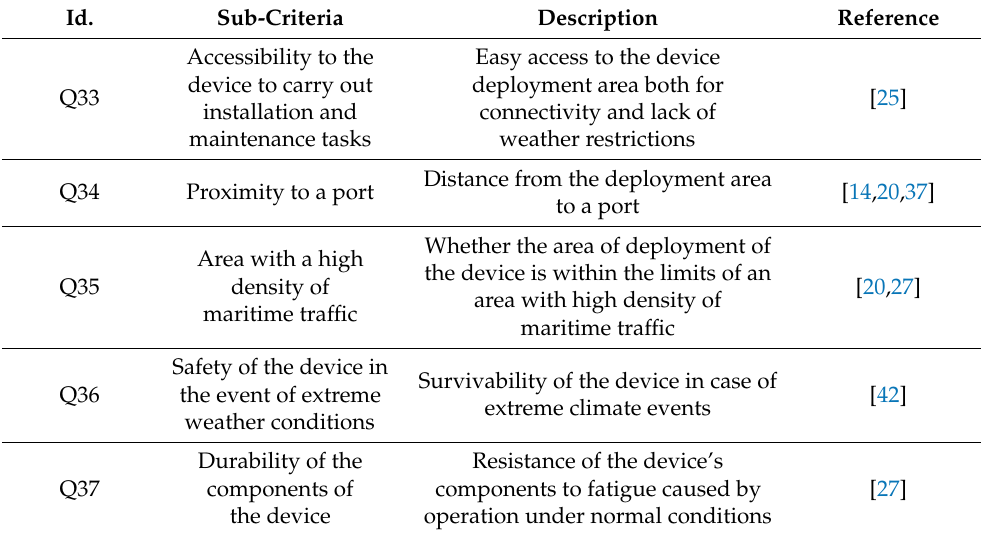
Table A9. Block 8: Influence of logistical factors. Q33 to Q37. Id.